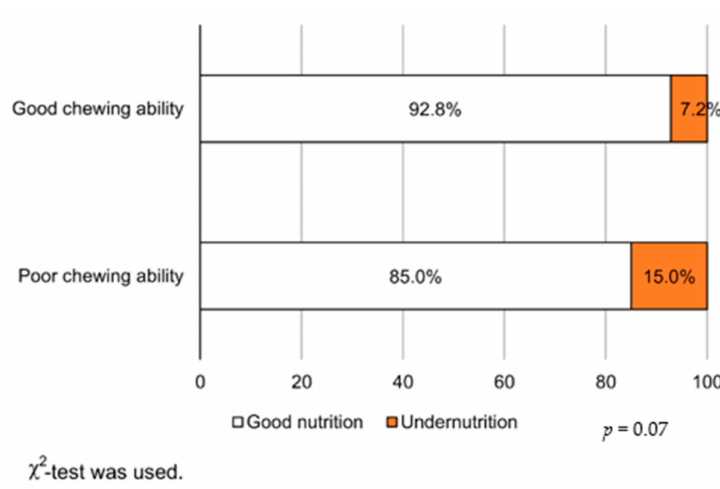
Figure 3. Rates of undernutrition due to differences in chewing